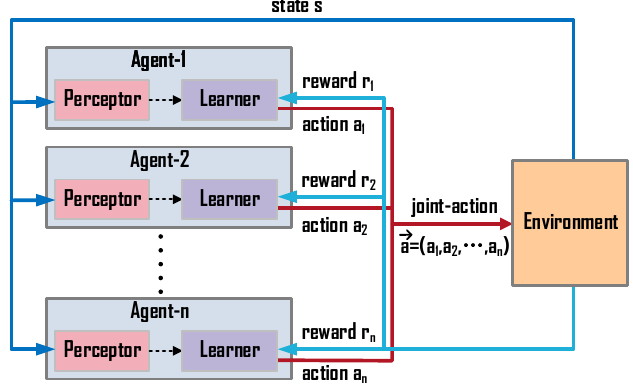
Figure 2. Principle diagram of